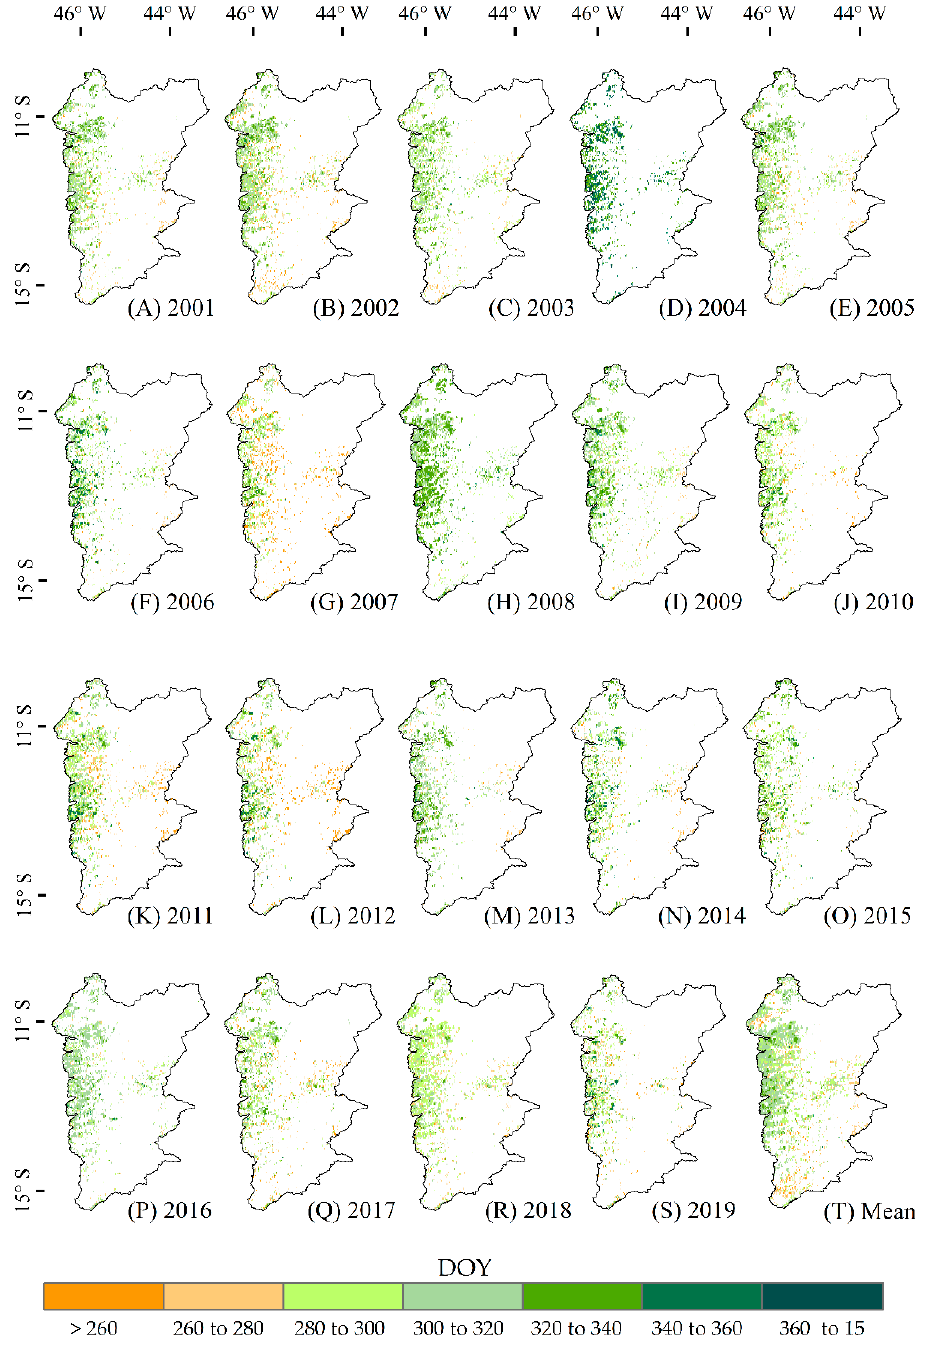
Figure 4. Sowing dates in rainfed areas in Western Bahia from 2001 to 2019 ( A – S ). Panel ( T ) shows the average sowing date for each